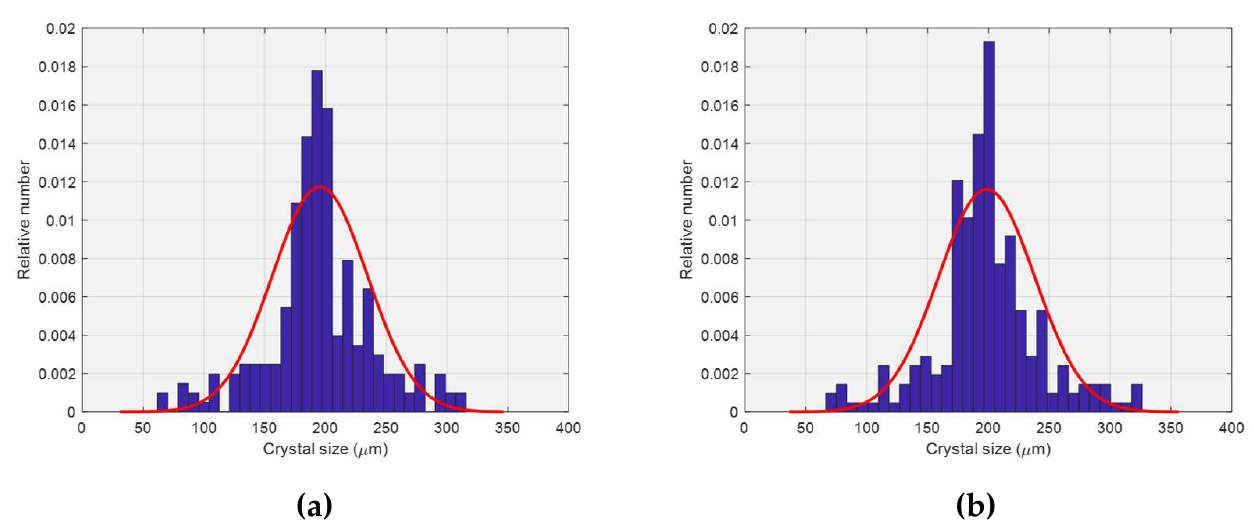
Figure 9. CSDs of LGA crystals: ( a ) CSD using in situ image measurement; ( b ) CSD using off-line measurement.